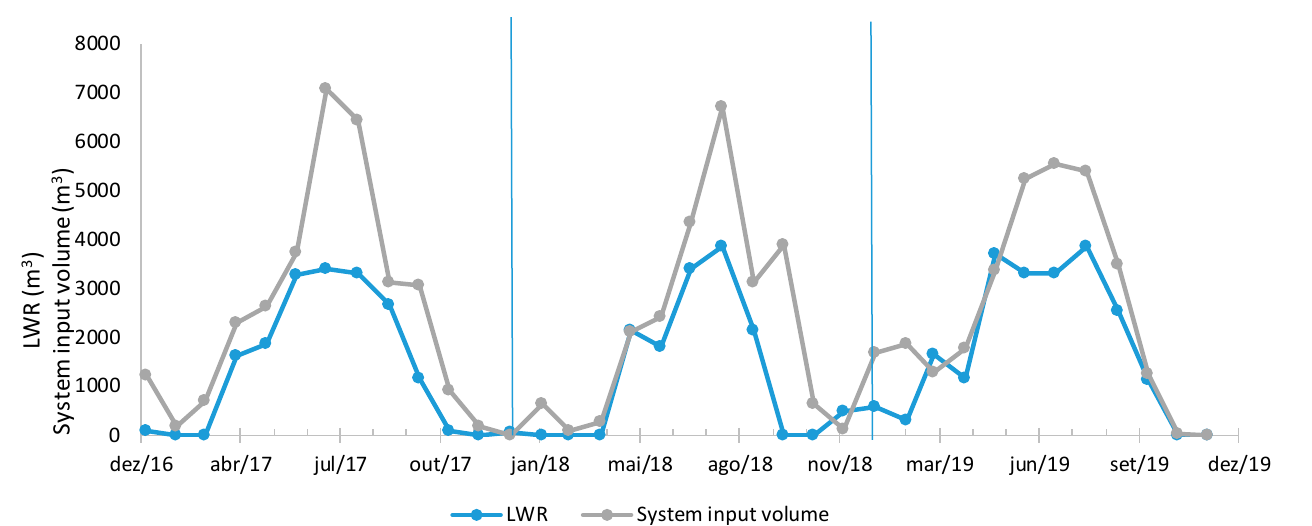
Figure 6. Landscape water requirements and system input volume in case study 1 in 2017, 2018 and 2019.